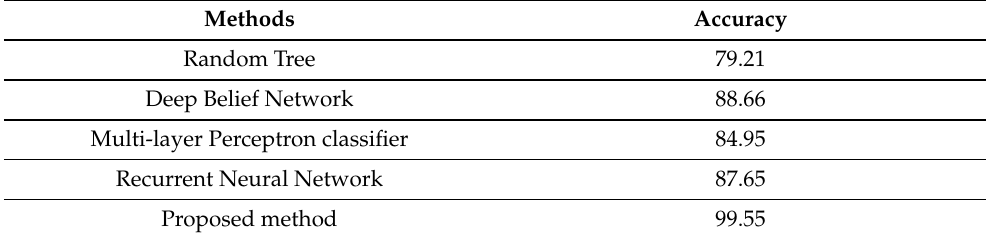
Table 4. Accuracy comparison with other